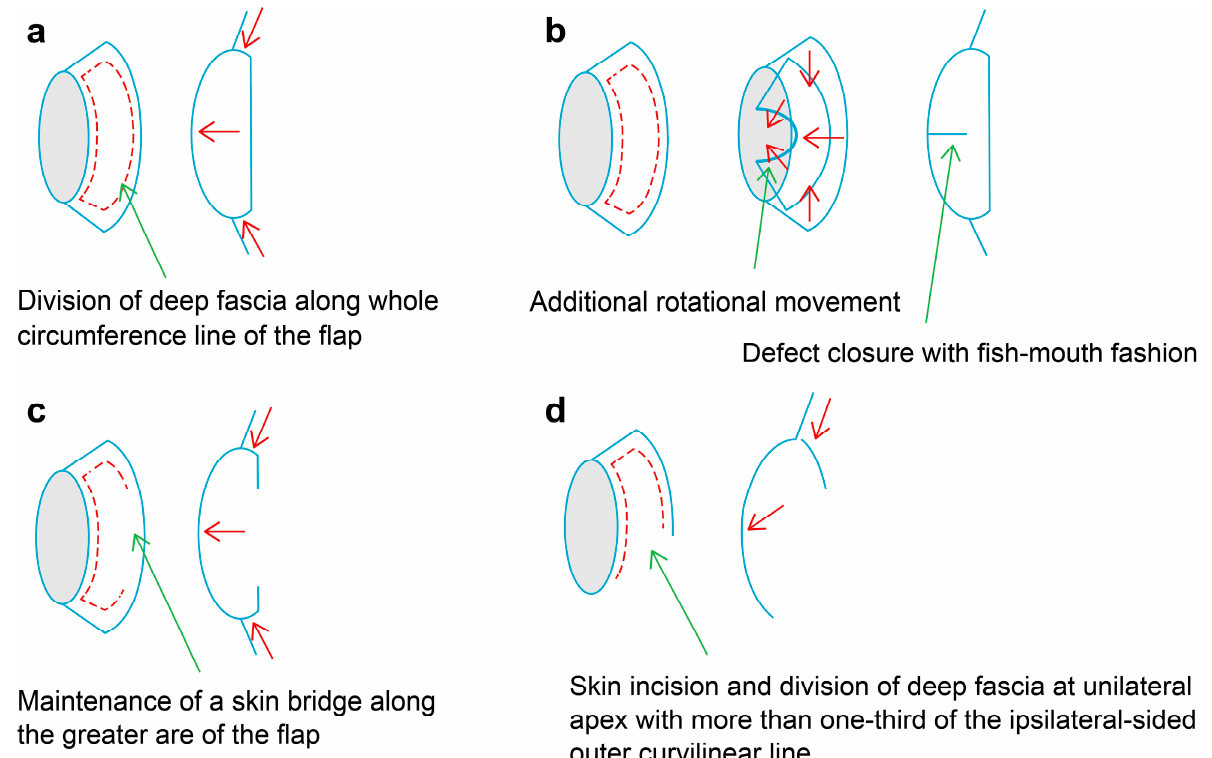
Figure 1. A basic illustration of the four modifications of the keystone perforator island flap (KPIF) used in this study. ( a ) Modified Type II KPIF. ( b ) Omega variation closure (OVC) KPIF. ( c ) Sydney melanoma unit modification (SMUM) KPIF. ( d ) Hemi-KPIF. Red dotted lines represent the division of deep fascia, and red arrows represent the direction of flap movement. (Reprinted from Keun Hyung Kim et al. [11], with permission from Hindawi).